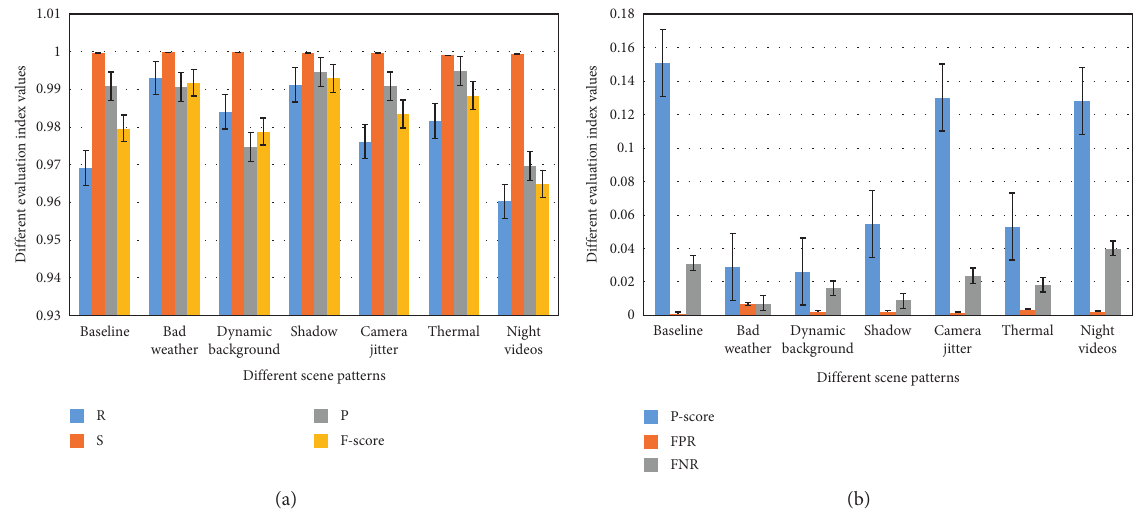
Figure 7: The average evaluation index results of the DFCN model in various scenarios. (a) Difference (R) S. (P) and F-score with number of iteration. (b) Difference P-score, FPR, and FNR with number of iterations.